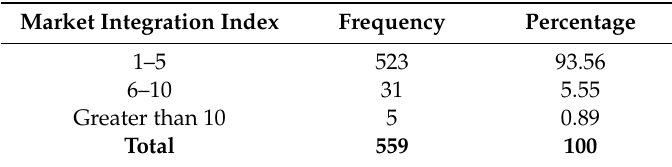
Table 4. The extent of farmers’ market integration.